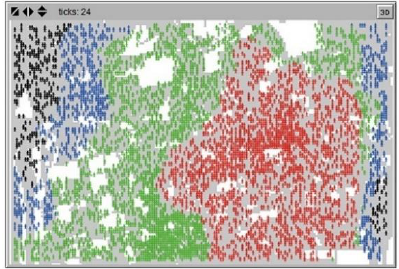
Figure 11-2: Segregation pattern resulting from satisfaction level of 50% in neighborhood radius 2